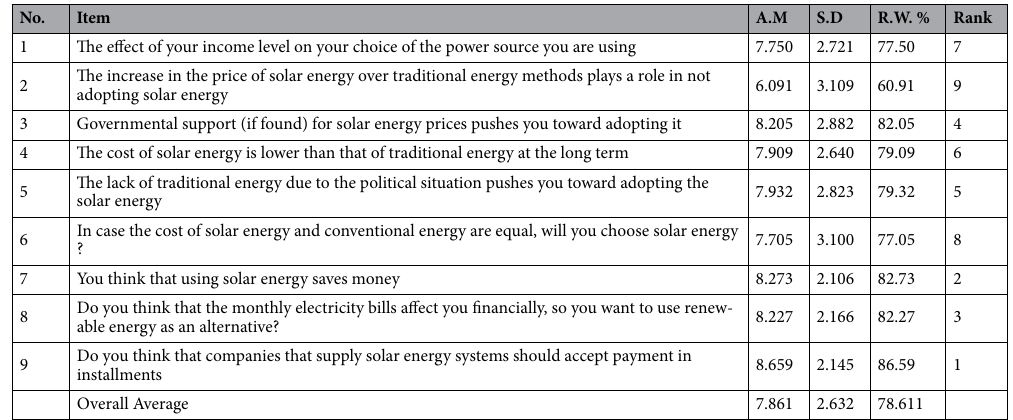
Table 1, the lowest three ranked items are heating and cooling devices with a relative weight of 42.73%, then wastewater treatment with relative weight of 41.59% and finally cooking has the least relative weight of 37.73%.